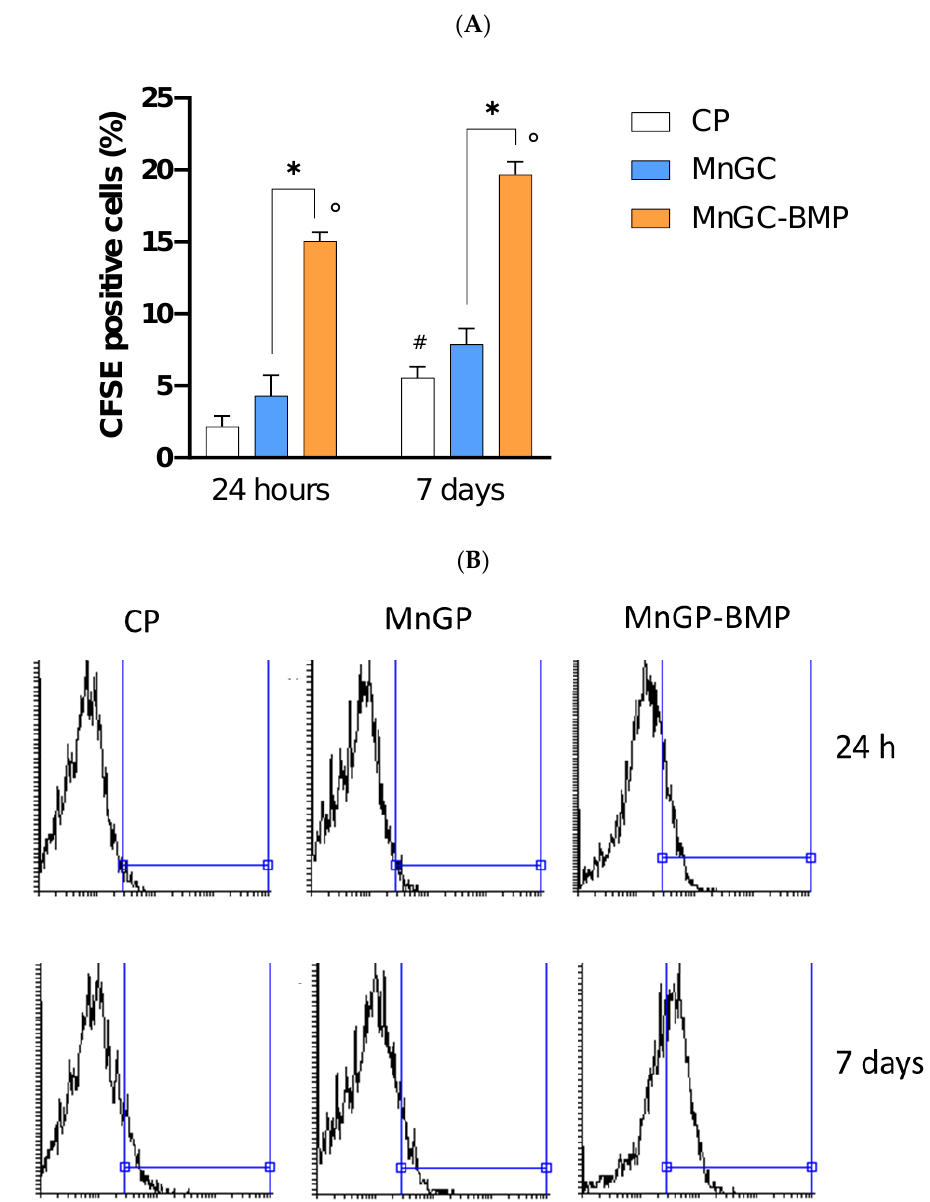
Figure 9. Cell proliferation was evaluated in h-osteoblast cells cultured on plastic supports (CP), MnGC, or MnGC-BMP for 24 h or 7 days. Data are reported as mean ± standard error of the % of cells positive at the fluorescent dye CFSE collected from 3 independent experiments, each performed in duplicate. # indicates p < 0.05 vs. CP at 24 h; ◦ indicates p < 0.02 vs. CP at the respective time of incubation; * indicates p < 0.02. ( B ) Representative histogram plots of data in ( A